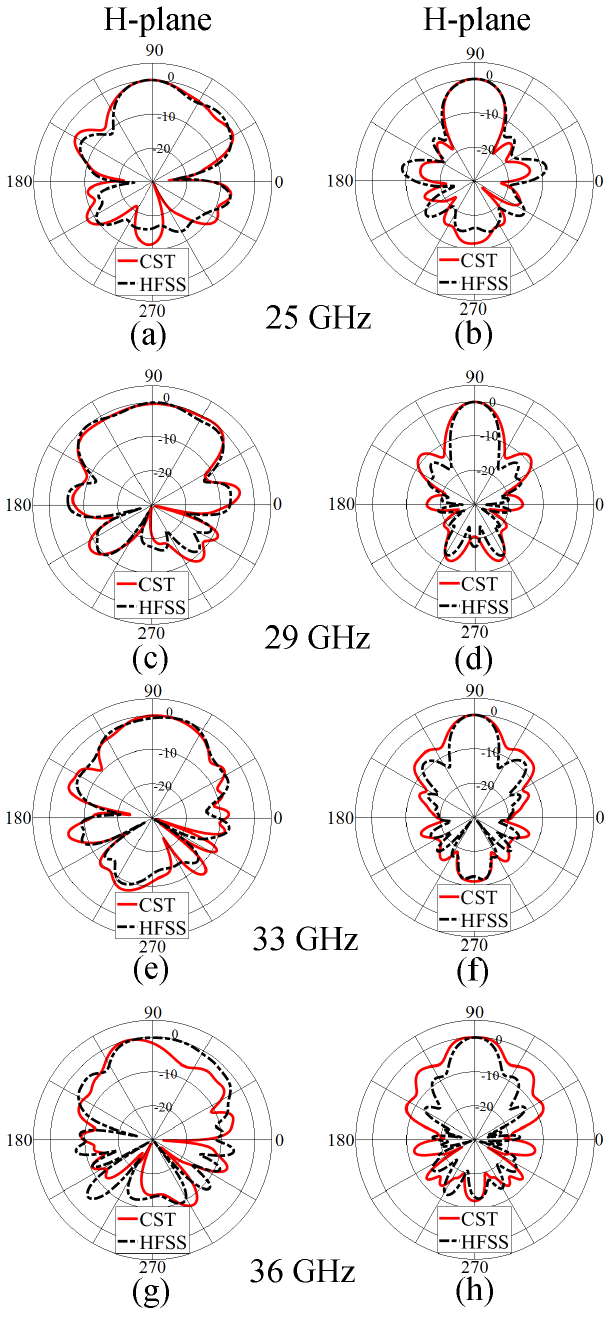
FIGURE 6. Normalized E- and H-plane radiation patterns of the proposed antenna at 25, 29, 33 and 36 GHz.